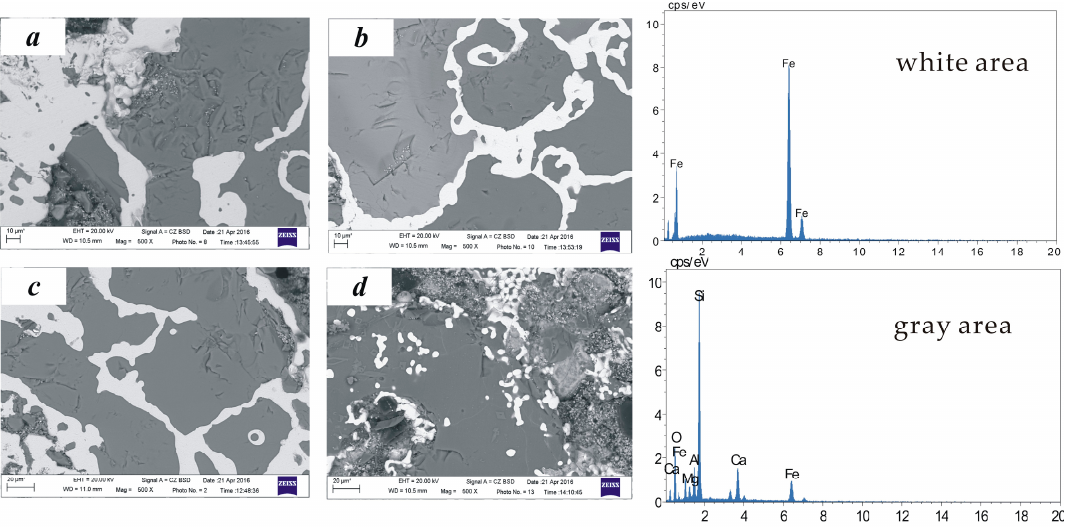
Figure 9. SEM images and EDS analysis results of the metallization pellets. ( a ) layer 1; ( b ) layer 2; ( c ) layer 3; ( d ) layer 4.